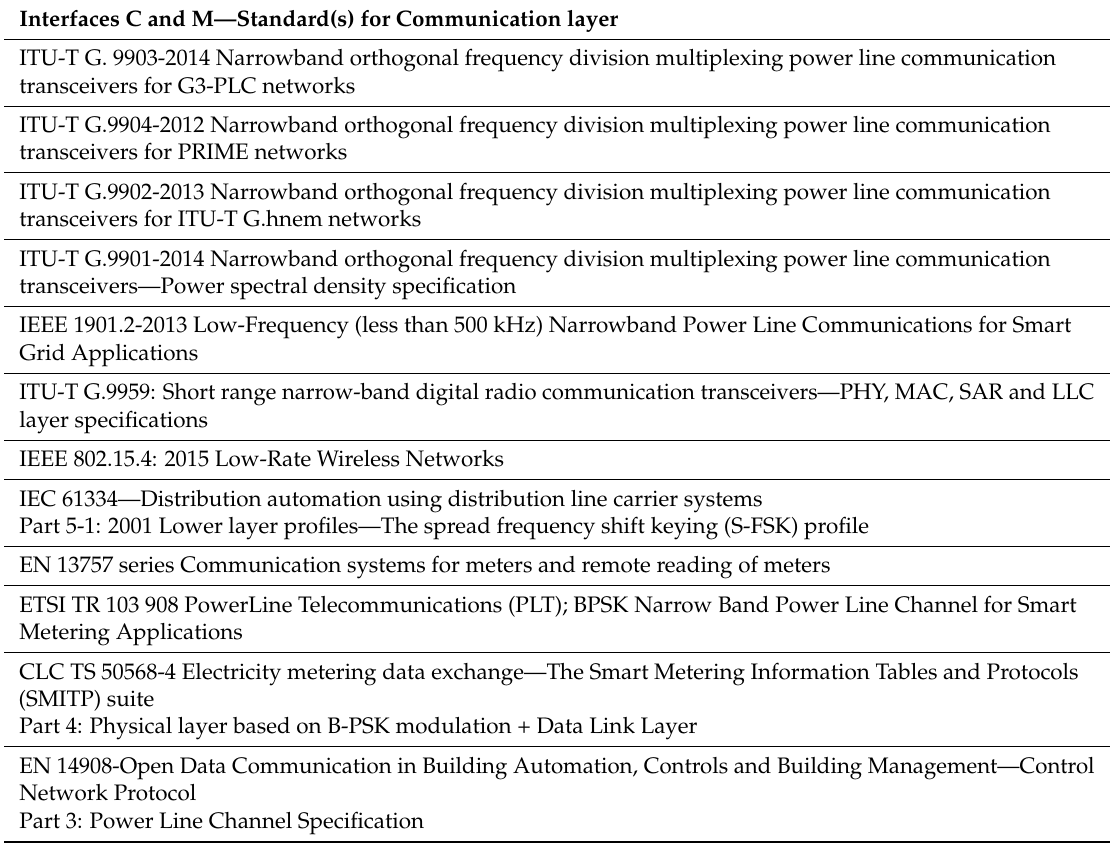
Table 5. Interfaces C, M and standards for the communication